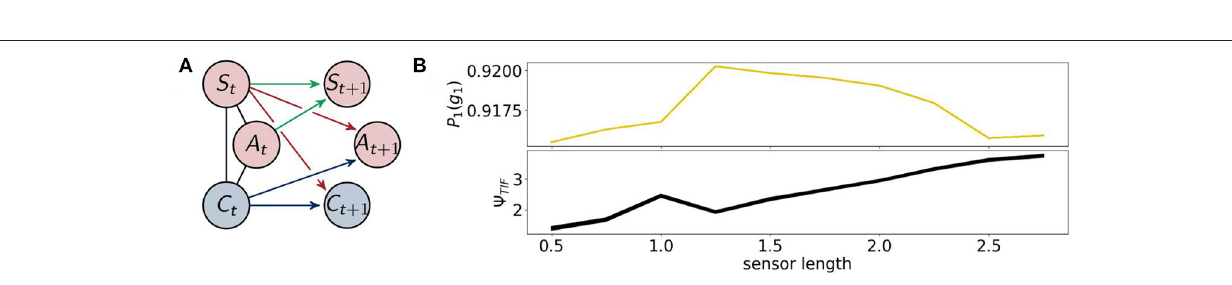
FIGURE 7 | (A) The architecture of the fully coupled agents and (B) the probability of survival (top) and the total information flow 9 TIF (bottom).